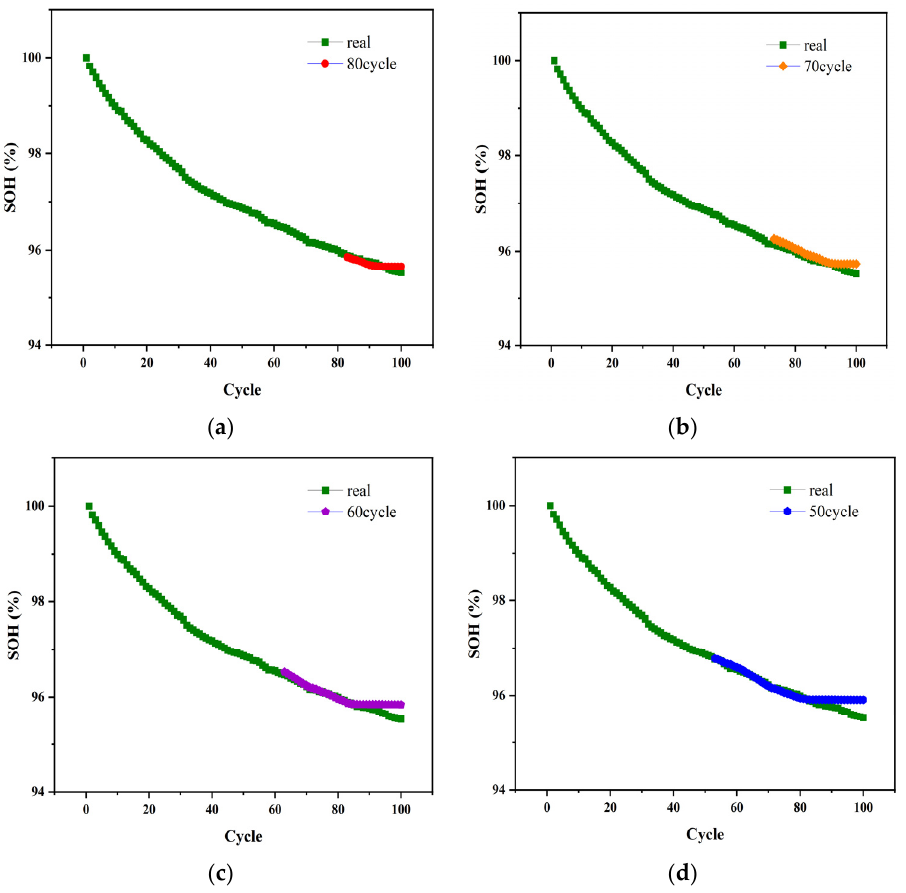
Figure 8. Transfer learning on the Mendeley dataset. ( a ) 80% of the training data. ( b ) 70% of the